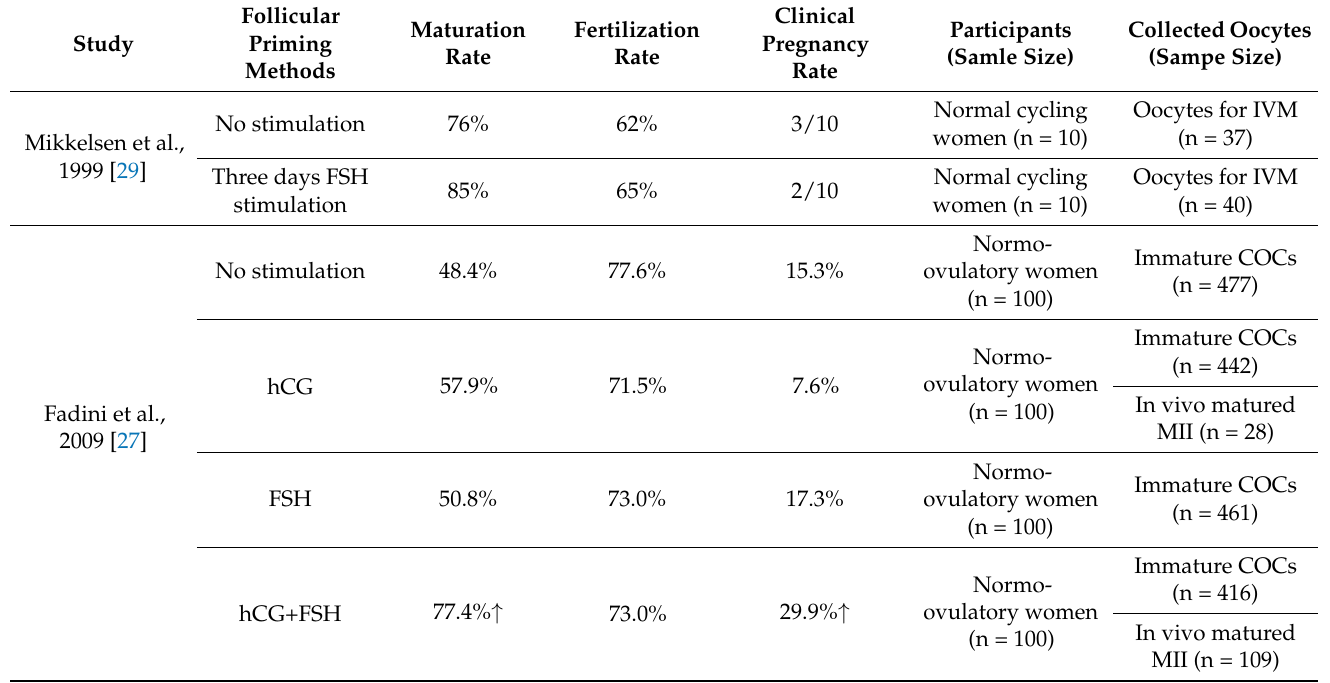
Table 1. Influence of follicular priming methods on human oocyte in vitro maturation